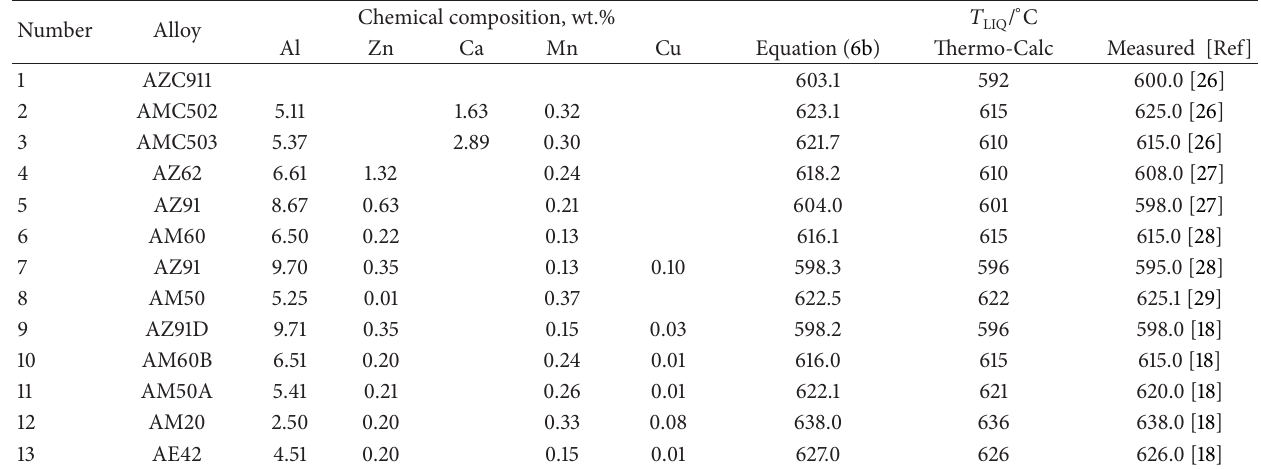
Table 3: Chemical composition of magnesium alloys (wt.%) calculated liquidus temperatures using (6b), Thermo-Calc, and the measured. Number